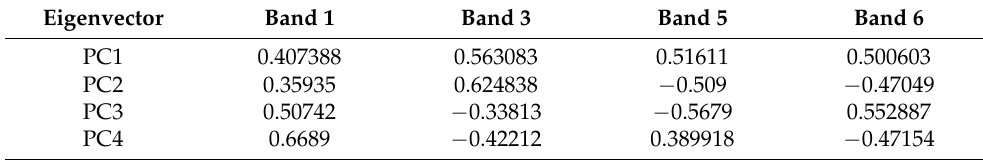
Table 11. Eigenvector loading for PC bands 1, 3, 5, and 6.